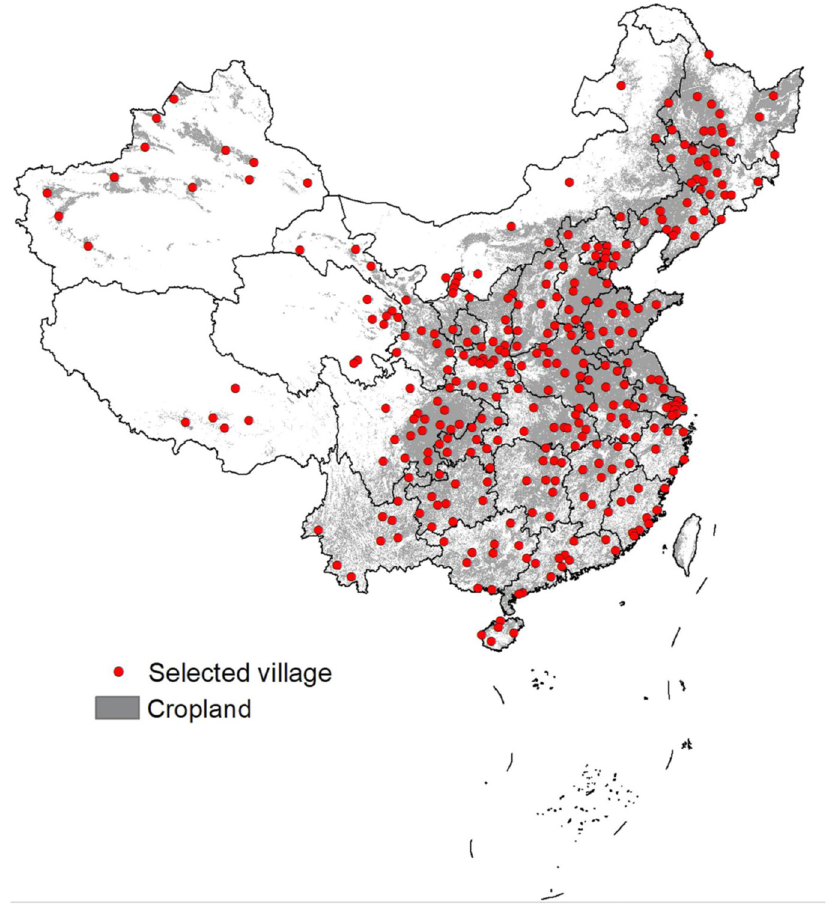
Figure 1. Location of the selected villages for the survey. Source: [50].